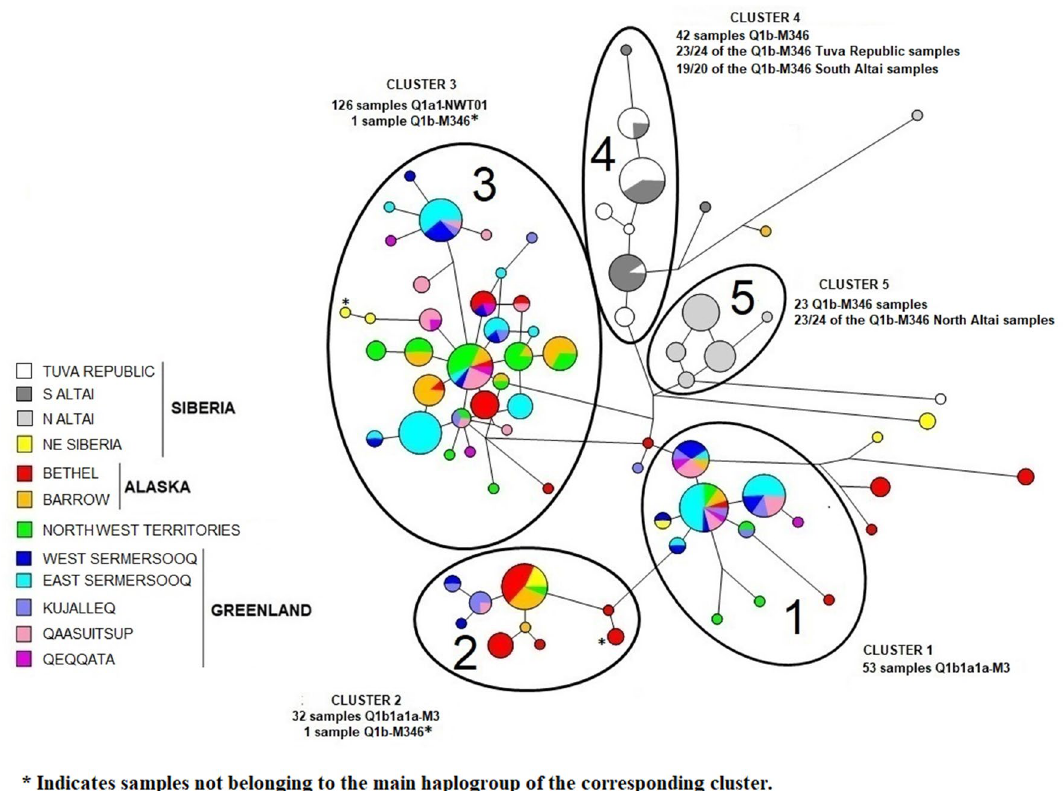
Figure 4. Network analysis based on haplogroup Q Y-STR